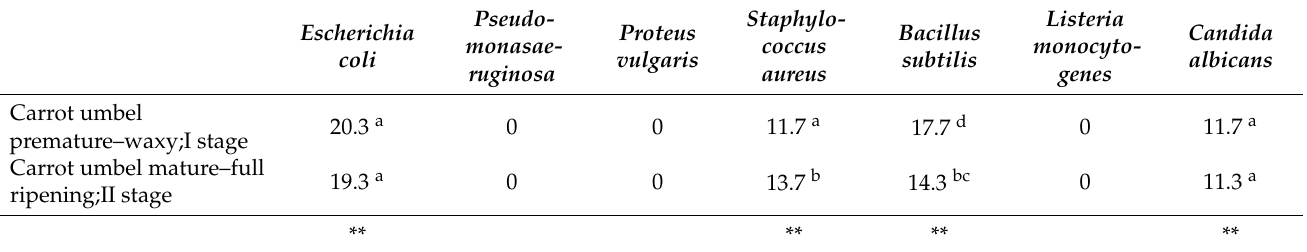
Table 3. Antimicrobial activity (inhibition zone, mm) of essential oils from wild carrot from